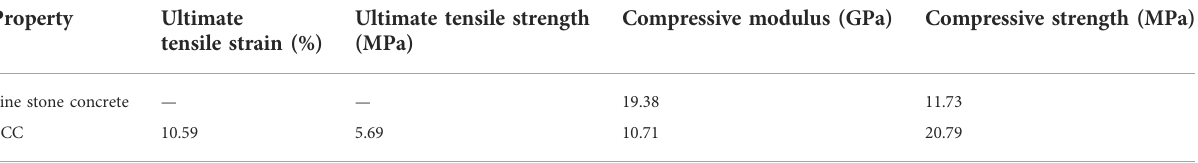
TABLE 3 Mechanical properties of materials used in ECC and fi ne stone concrete. Property